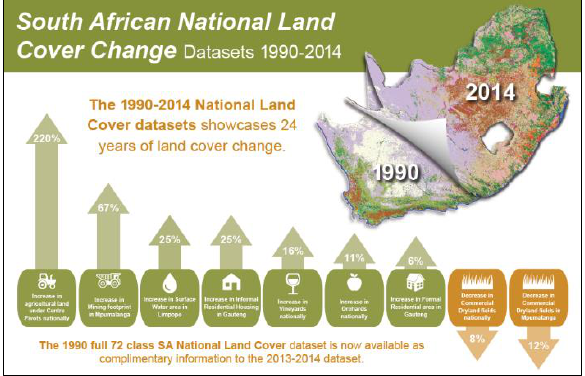
Figure 2. GTI’s 1990 and 2014 Standardised South African Land-cover